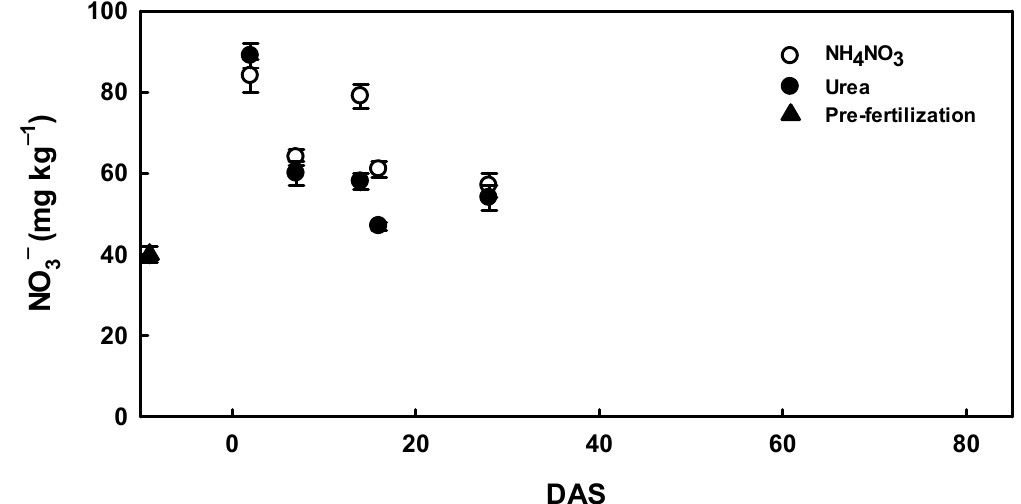
Figure 4. NO 3 − content in soil fertilized with ammonium nitrate (open circles) and urea (filled circles). Data are means ( n = 4) ± SE.